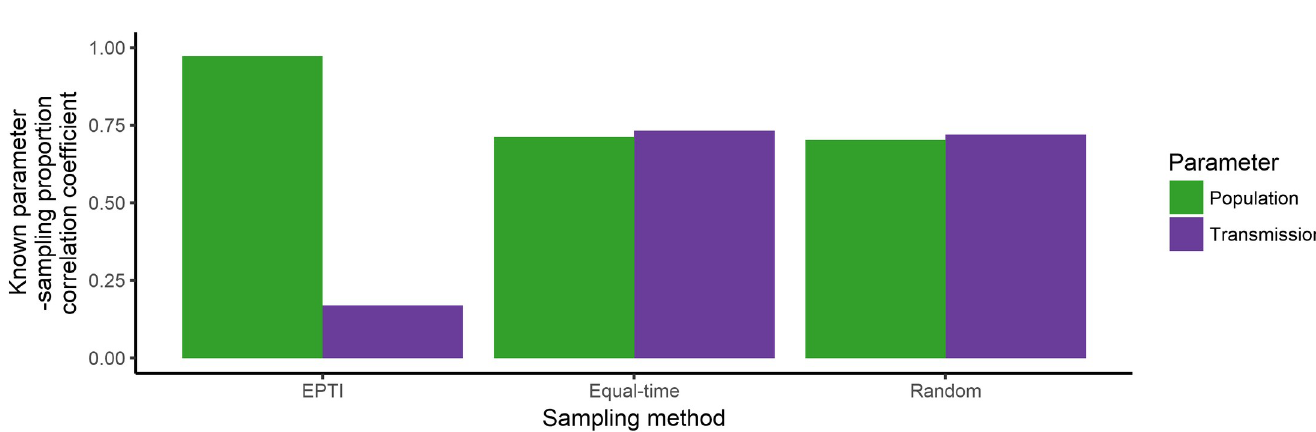
Fig 16. Bar graph of the correlation coefficients between the proportion of isolates sampled from each host population and the known population and transmission parameters for 12 EPTI simulated outbreaks that 100 isolates were randomly sampled from, and 23 simulated outbreaks that 100 isolates were sampled randomly and equally over